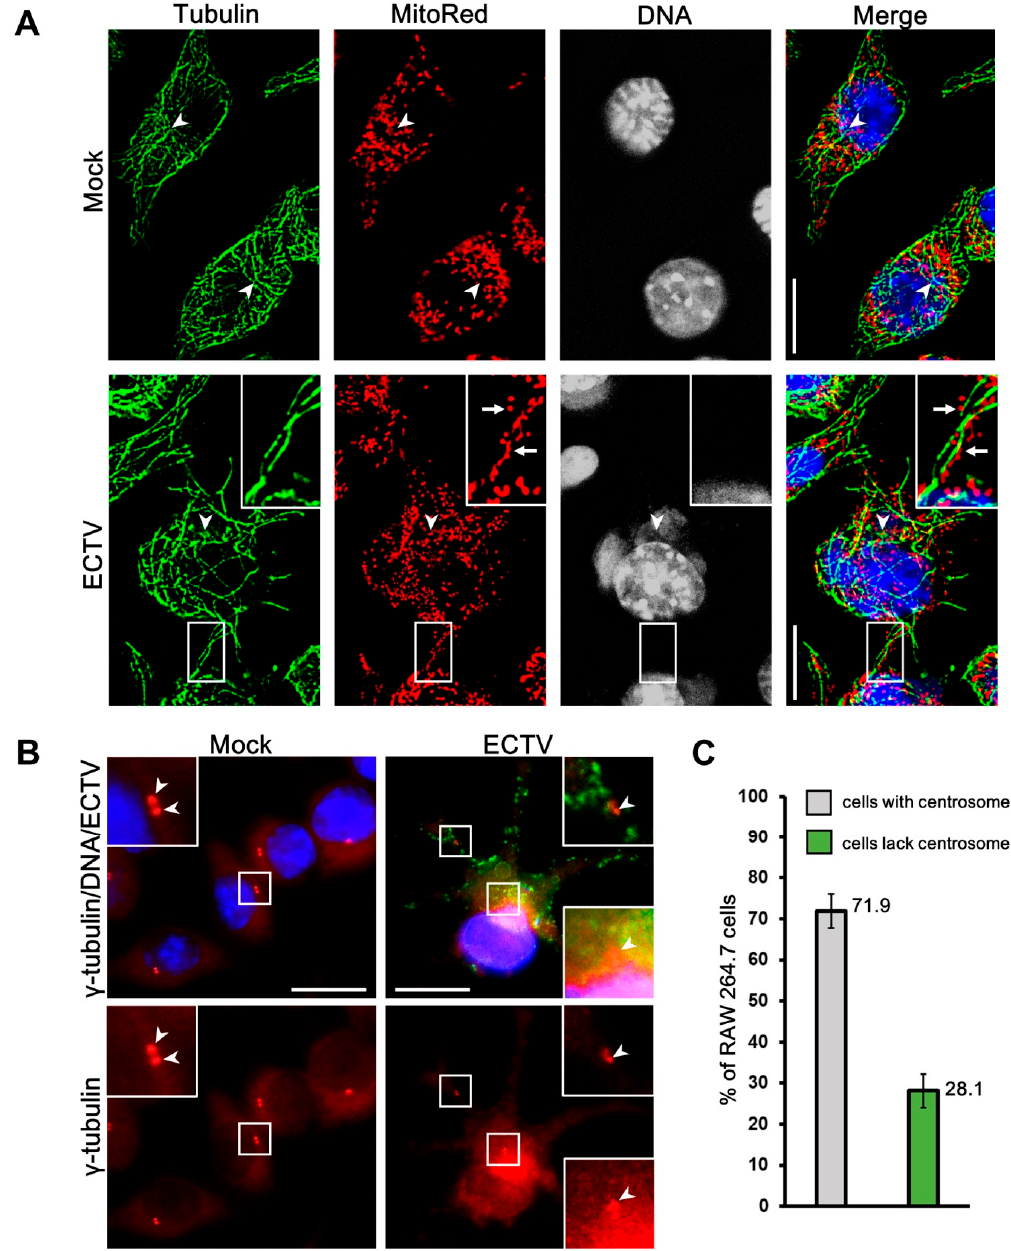
Figure 4. Tubulin cytoskeleton in RAW 264.7 cells at 18 hpi with ECTV. ( A ) α -tubulin staining. ( B ) γ -tubulin staining. ( C ) Percentage of virus-infected cells that show the centrosome or not. Arrowheads indicate microtubule organizing center (MTOC) with lack of mitochondria in mock cell or disappearance of MTOC that was replaced with viral factory and mitochondria in virus-infected cells ( A ) or centrioles ( B ). Arrows indicate punctate mitochondria on microtubules in mock-infected cells ( A ). Data from three independent experiments are presented as mean ± SD ( n = 100 cells). Scale bar: 10 µm.